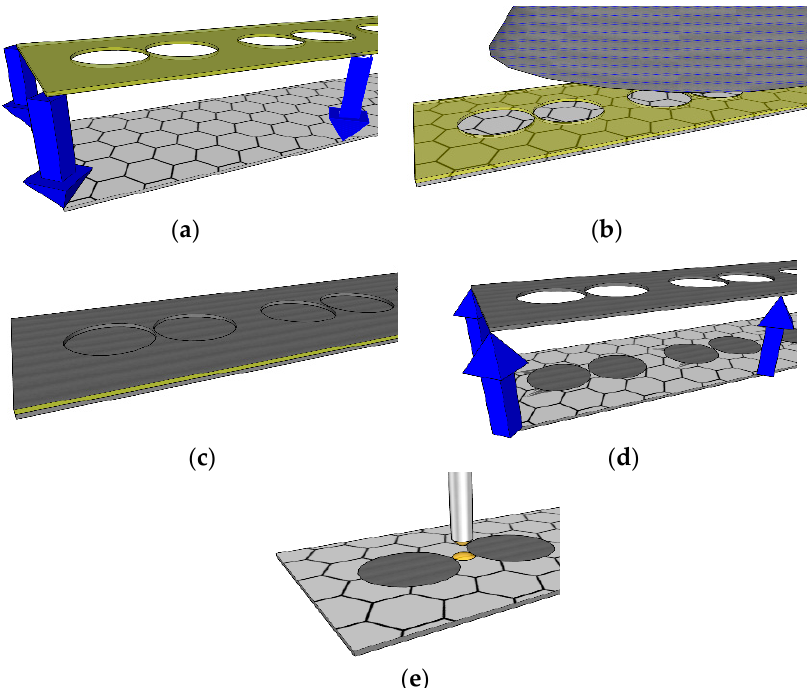
Figure 1. Fabrication process for graphene field-effect transistors with spray-on liquid-metal electrodes: ( a ) electrode patterns are cut into a Polyethylene Terephthalate (PET) substrate and placed flush on graphene surface to act as stencil; ( b , c ) liquid-metal is sprayed on the graphene surface with a paint gun; ( d ) the stencil is carefully removed, resulting in patterned electrodes on graphene; ( e ) an electrolytic top-gate material (honey) is drop-casted between the electrode pair to complete the device.